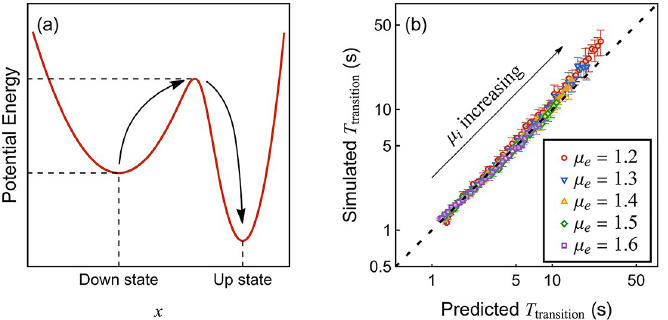
Fig 14. Prediction of transition times using Eyring-Kramer’s law. Panel (a) represents schematically the effective double-well potential energy landscape used to predict the transition rate for the bistable network. In principle, such an energy landscape should at least be four-dimensional as it involves 4 groups of neurons. However, an one-dimensional effective model already offers good predictions as we find that a single switching direction (arrow) dominates the transition dynamics. Panel (b) shows that the transition times inferred from our RMF model (horizontal axis) predict the empirical transition times obtained from Monte-Carlo simulations (vertical axis). Each data point corresponds to a , μ ). μ ranges from 1.2 to 1.6 in the increment of 0.1. Data points with distinct μ ’s are different pair of parameters ( μ e i e e shown in different colors and marks. μ i ranges from 4 to 14 in the increment of 0.25. The arrow in the figure indicates the direction of increasing μ i . For the predicted transition times, we apply the Eyring-Kramer’s law by estimating the potential energy of our system from a mixture of two normal distributions. Such distribution is constructed using solely the means and standard deviations of the up and down states computed from the RMF calculation. Please refer to S1 Appendix for more details. For the simulated transition times, we simulate the dynamics of our bistable network until 100 transitions between up and down states are accumulated. The transitions are detected using a hidden Markov model. This process is repeated 16 times. During each repetition, we record the total time T ( k = 1, ��� , 16). The k P 16 simulated transition times of the network are then computed by T ¼ ð = 100 Þ = 16 . The standard T transition k k ¼ 1 deviations of the transition times (indicated by error bars) over these 16 repetitions are computed by taking the square P 16 root of ð ð T = 100 Þ 2 (cid:0) T 2 Þ = ð 16 (cid:0) 1 Þ . Parameters: k transition k ¼ 1 K total = 40, h = 1 Hz, a = ln(100)/20 � 0.23, τ = 10